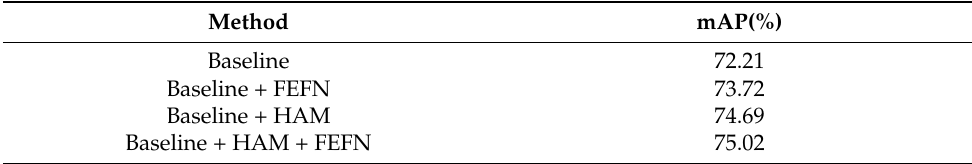
Table 3. Results of ablation experiments.